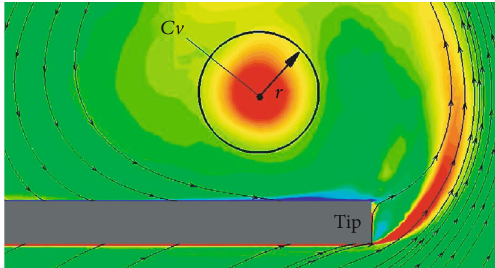
Figure 12: The schematic of quantitative analysis.